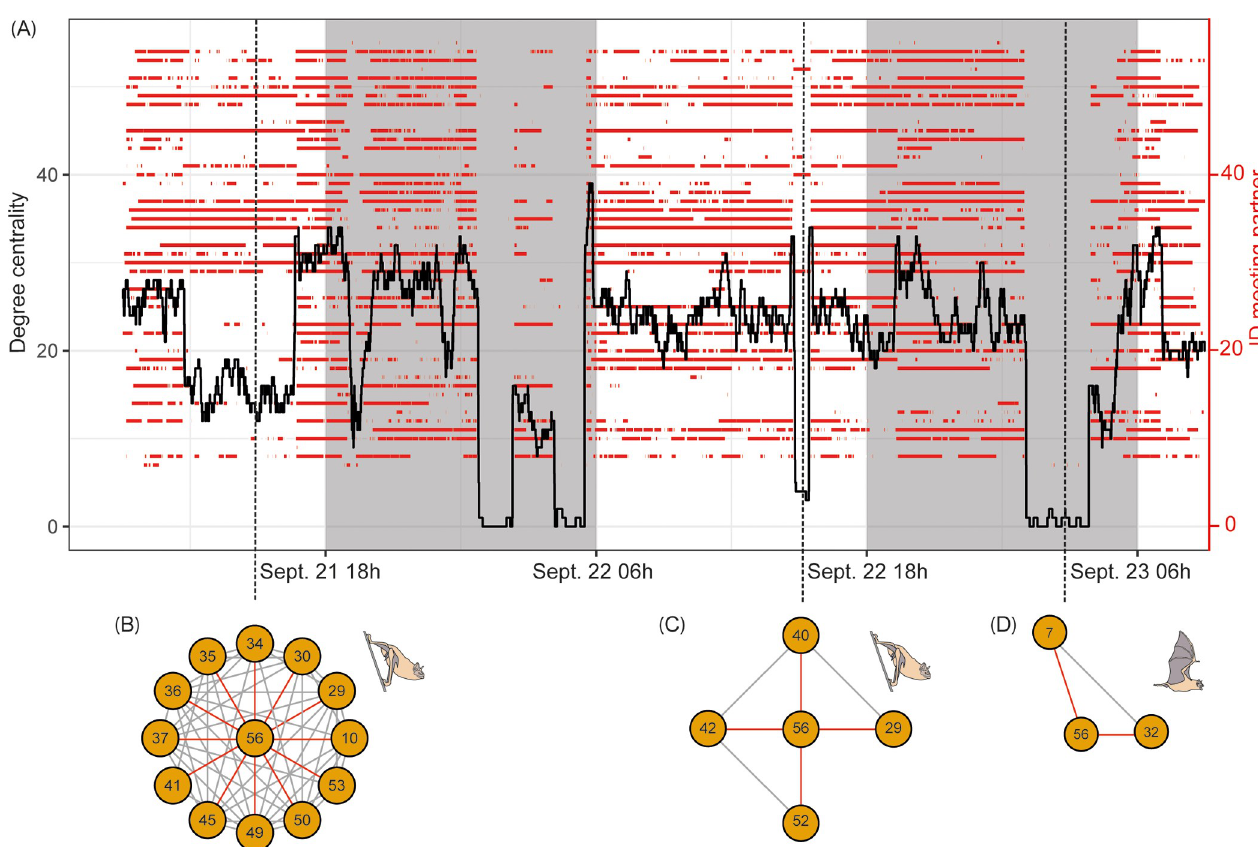
Fig 2. High-resolution association data in wild vampire bats. (A) Meeting history of a single vampire bat (ID 56; 50 tagged bats in total) with other tagged bats. Red lines show meetings between bat 56 and other tagged bats (right-hand y-axis). The black line shows the degree centrality (number of associated tagged bats, left-hand y-axis) of bat 56 every 2 s. Date and time are on the x-axis. Shaded areas indicate night time. Vertical dashed lines show egocentric social networks at each snapshot of time during roosting (B, C) and foraging (D). Associations with the focal bat are indicated by red lines. Data and software used to create this figure have been archived by GFBio (https://doi.org/10.7479/vd6t-7a92;